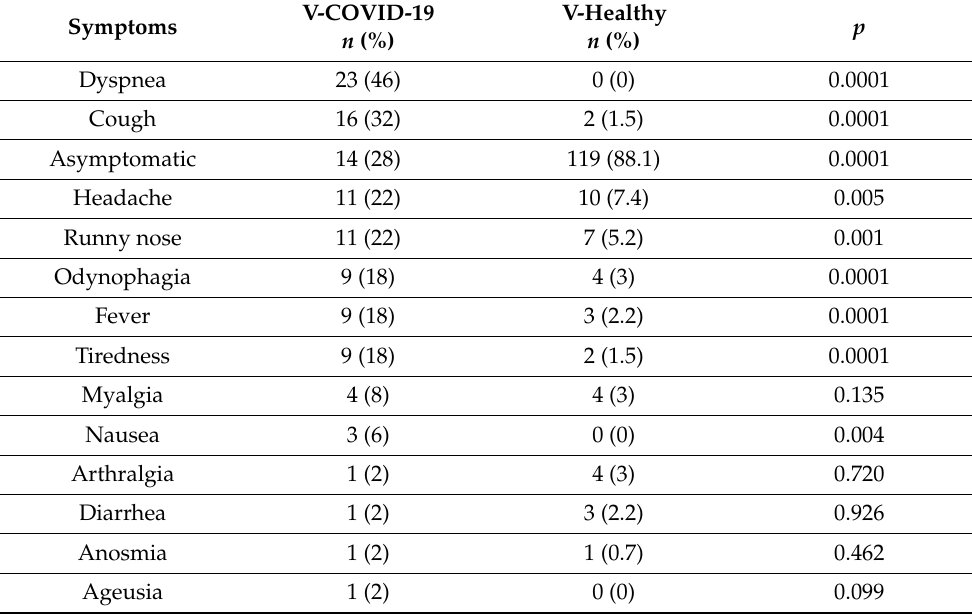
Table 4. Symptoms in the studied population.